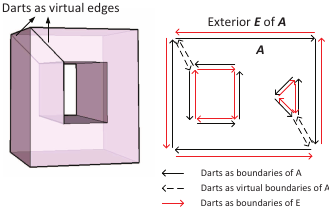
Figure 5. Darts as the virtual boundaries of 2-cells with holes